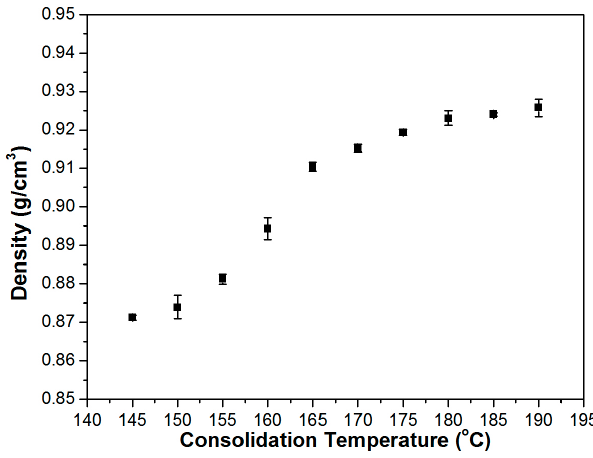
Figure 3. Density of the UD SRCs prepared at different consolidation temperatures.